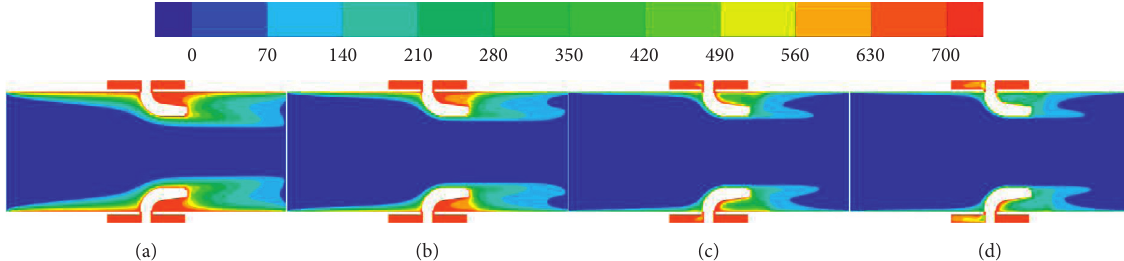
Figure 12: Temperature field distribution in fluid domain at 700 ° C. (a) 10m 3 /h. (b) 100m 3 /h. (c) 500m 3 /h. (d) 1000m 3 /h.